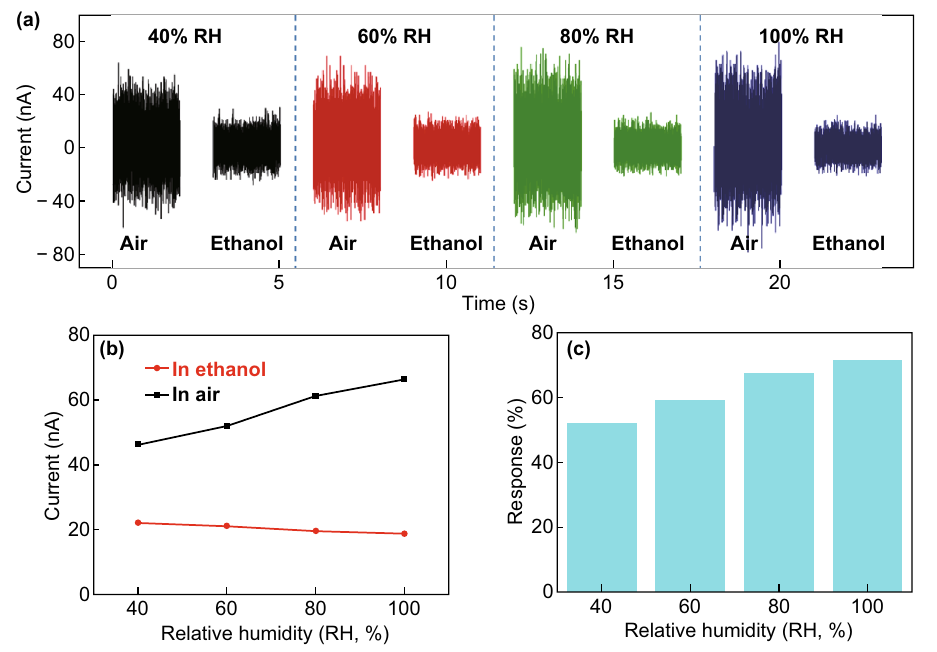
Fig. 7 Humidity influence on ethanol response in the PANI(SDS) sensing unit. a The output current of the PANI(SDS) sensing unit under airflow and 600 ppm ethanol gas flow in different humidity conditions (40%, 60%, 80%, and 100% RH). b The relationship between output current and relative humidity in airflow and 600 ppm ethanol gas flow. c The relationship between response and relative humidity